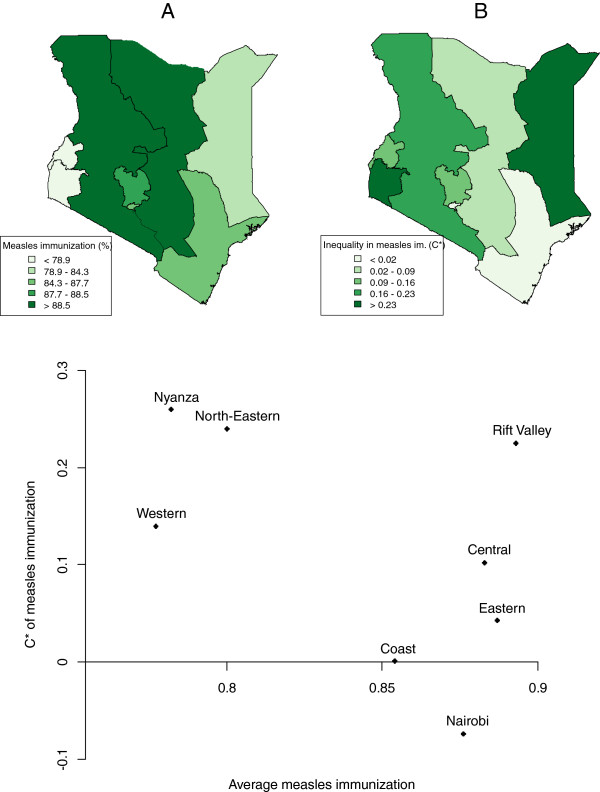
Regional distributions of average (A) and inequality in (B) measles immunization, Kenya, DHS 2008/09. * = Erreygers’ corrected concentration index [24].